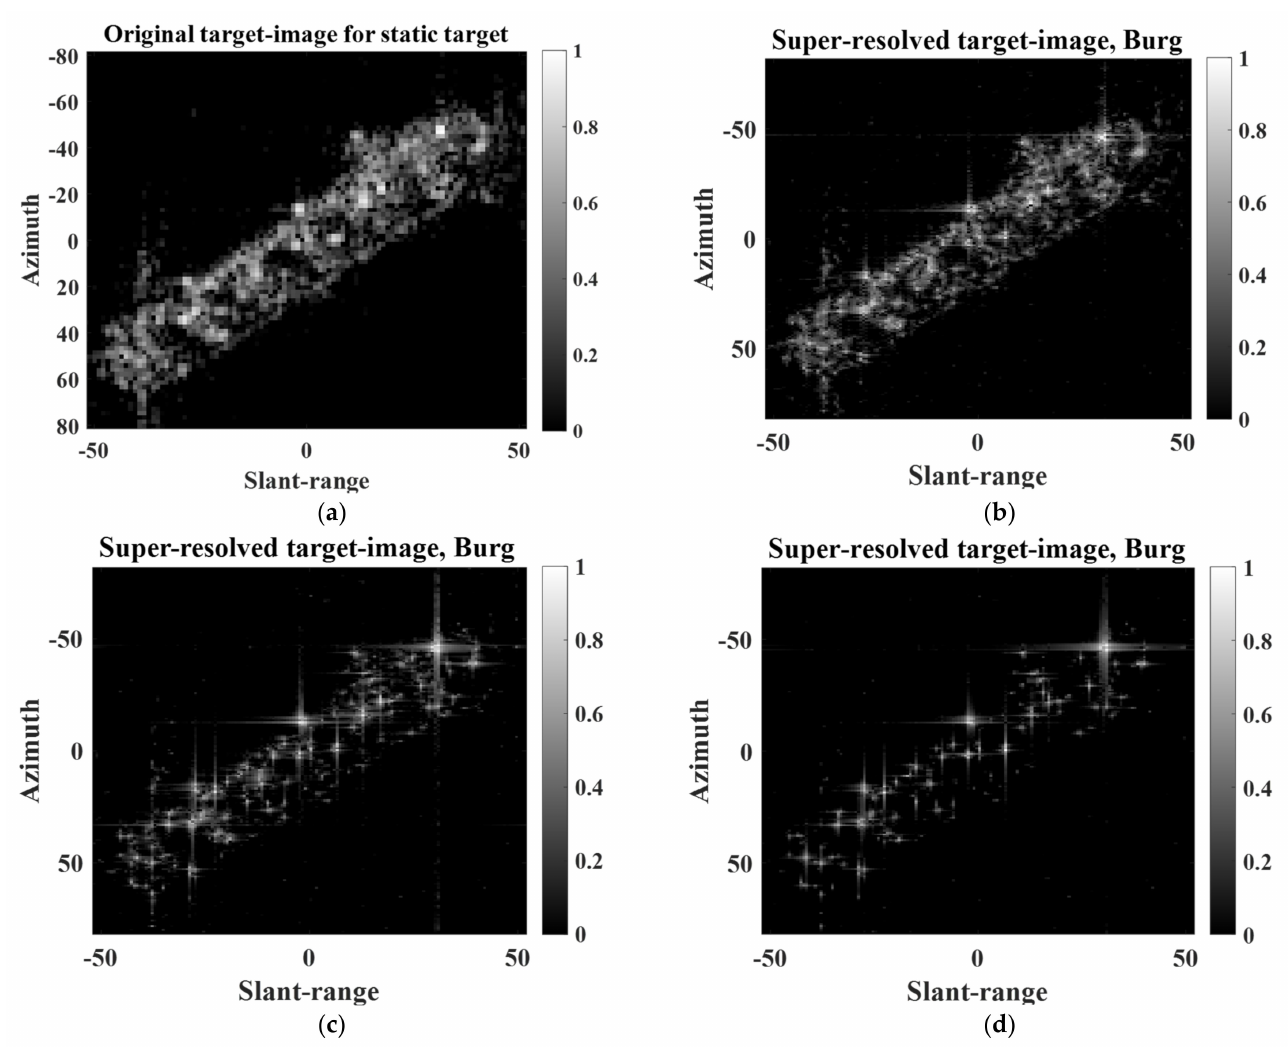
Figure 14. SR results for Figure 2a: ( a ) original, ( b ) α = 3, ( c ) α = 5, ( d ) α =